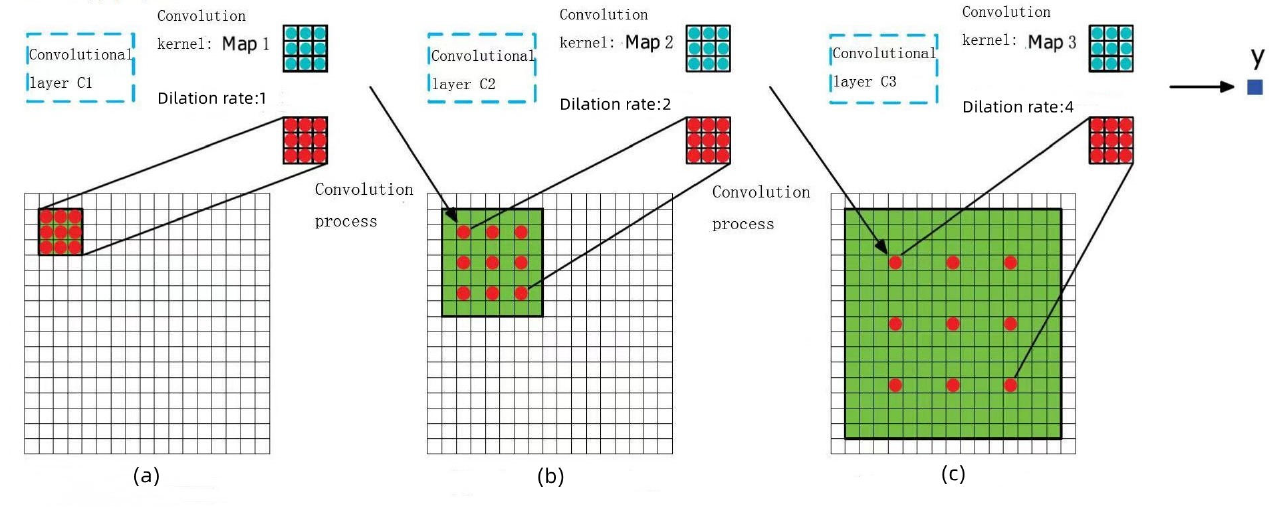
Figure 6. The dilated convolutional layer. ( a – c ) are, respectively, the convolution process with dilation rate k = 1, k = 2, and k =